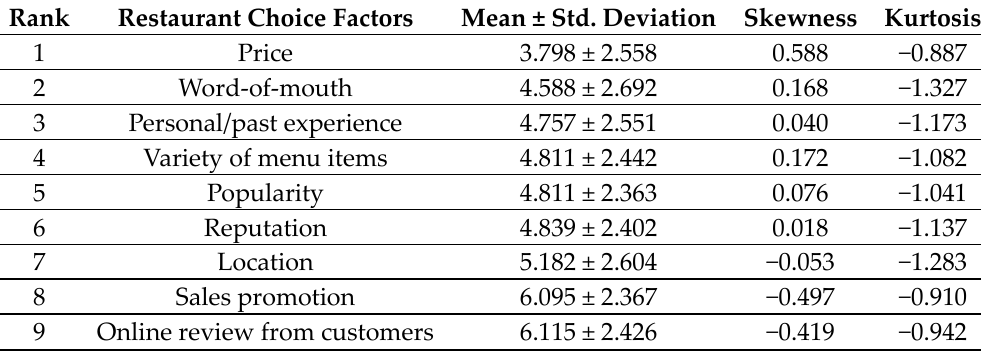
Table 1. Overall ranking of restaurant choice factors.